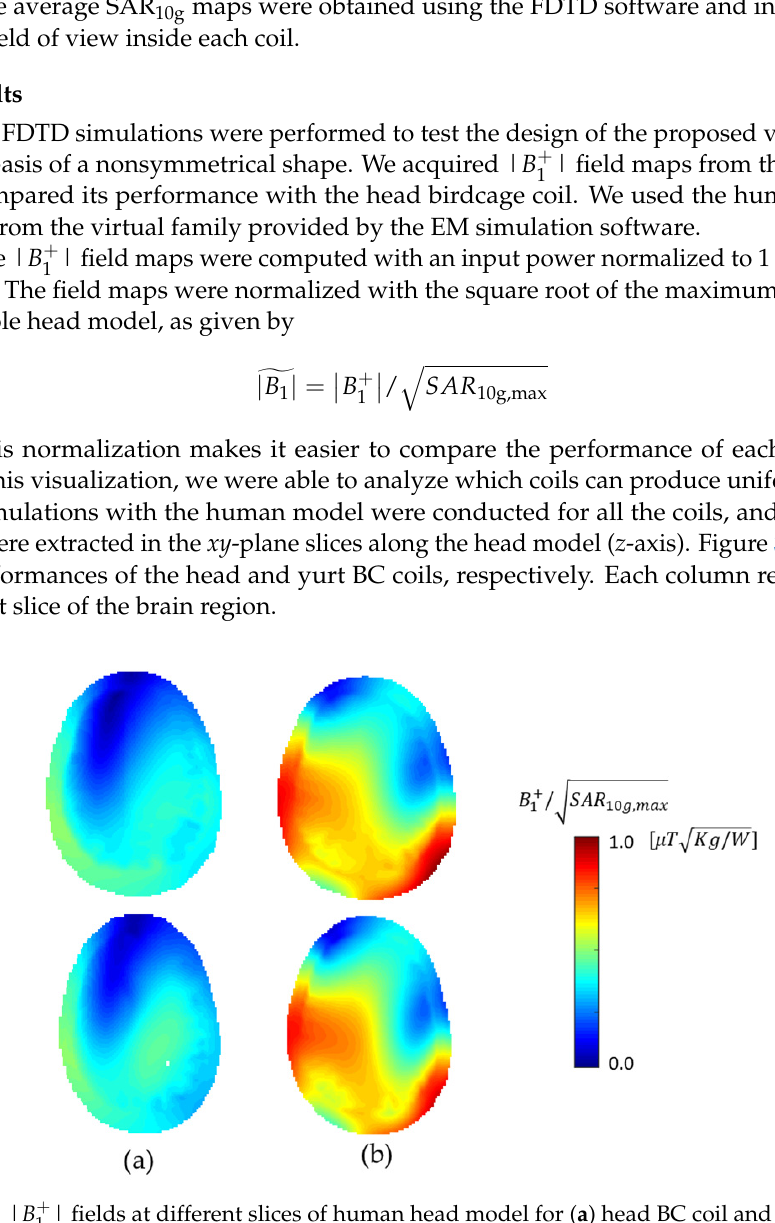
(cid:2878) | fields at different slices of human head model for ( a ) head BC coil and the ( b ) yurt Figure 3. | (cid:1828) (cid:2869) BC